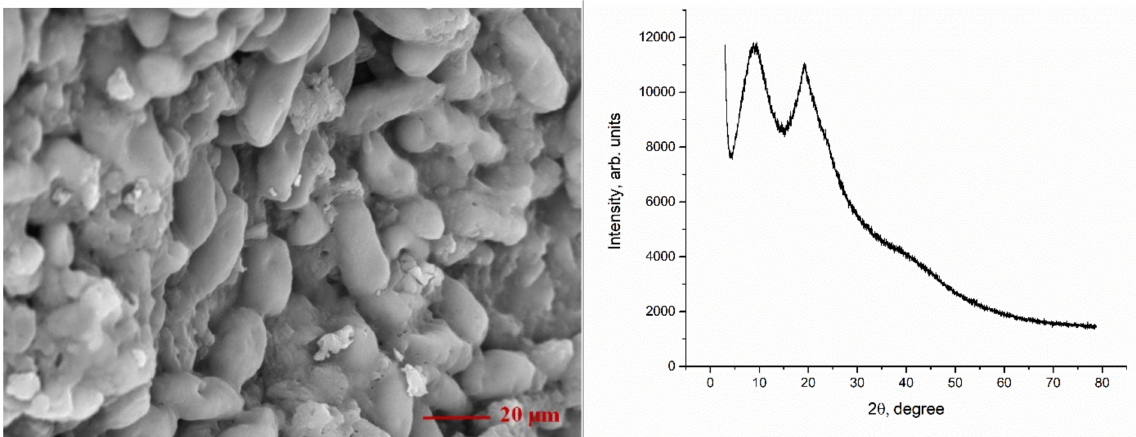
Figure 1. SEM image ( left ) and XRD pattern ( right ) of S. cerevisiae yeast biomass before biosorption